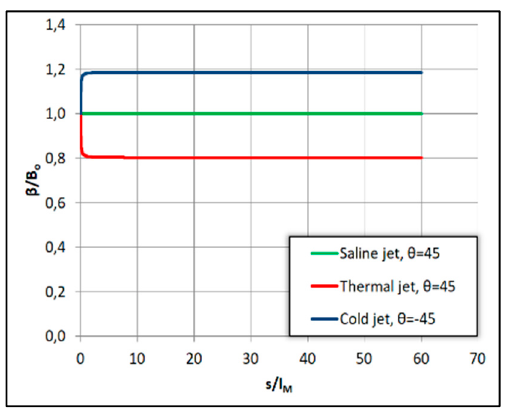
Figure 11. Normalized buoyancy flux β / Β ο of positively buoyant jet at θ ο = 45°.